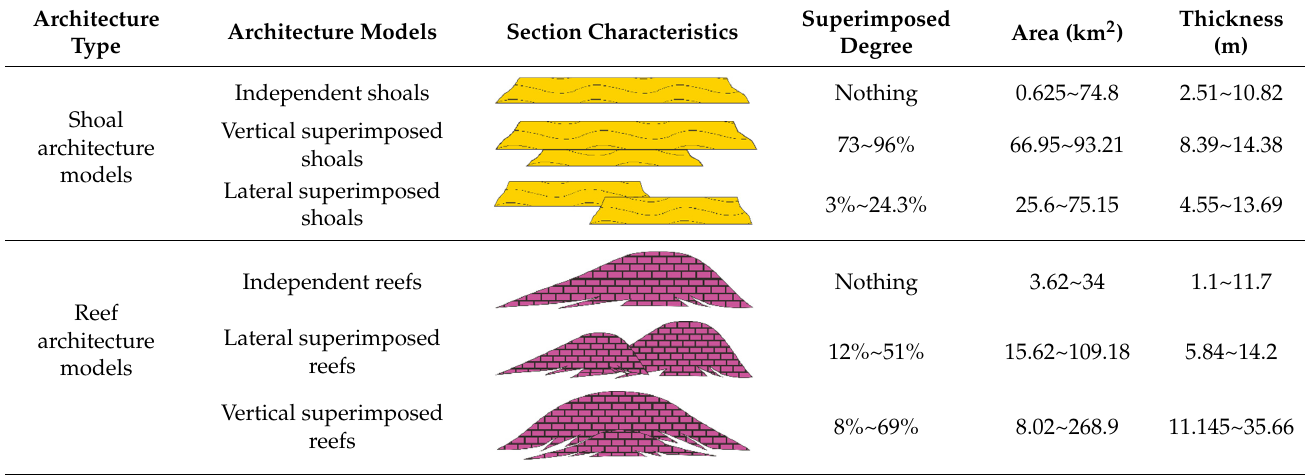
Table 3. Reservoir architecture model of platform margin shoal facies.